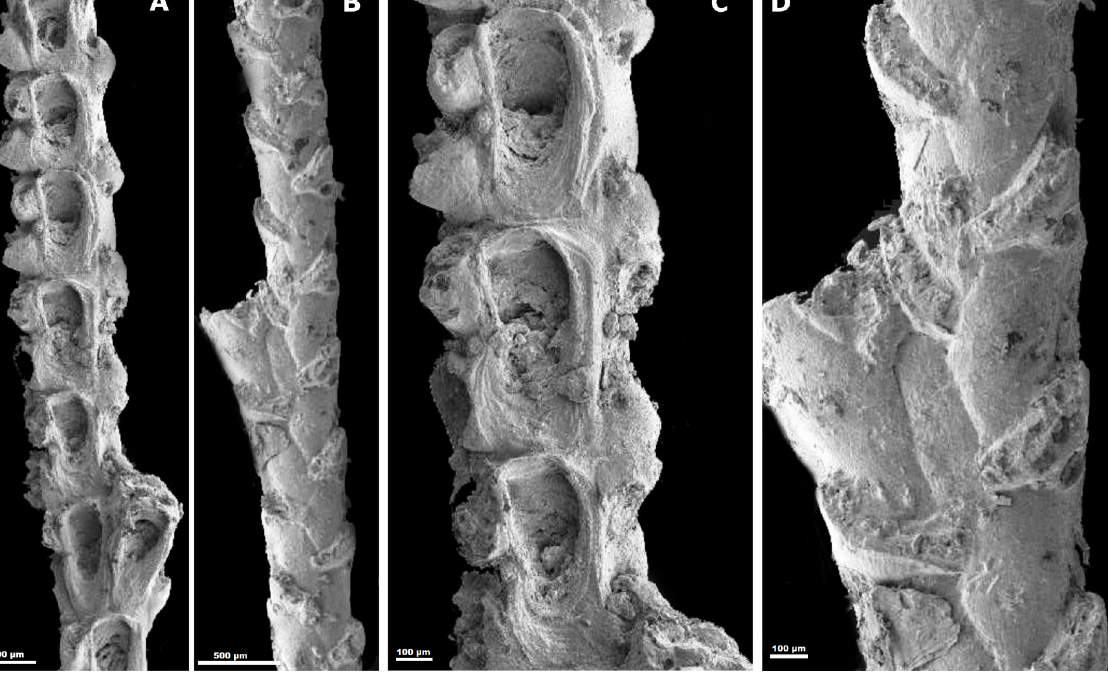
Fig. 2. Canda ukirensis sp. nov., holotype (GIS/B 431). A . Frontal view of the colony showing different autozooids, avicularia and vibracula. B . Dorsal view of the colony showing vibracular pores. C . Enlargement of the colony showing autozooids. D . Close-up of dorsal view of the colony showing vibracula with setal grooves and vibracular